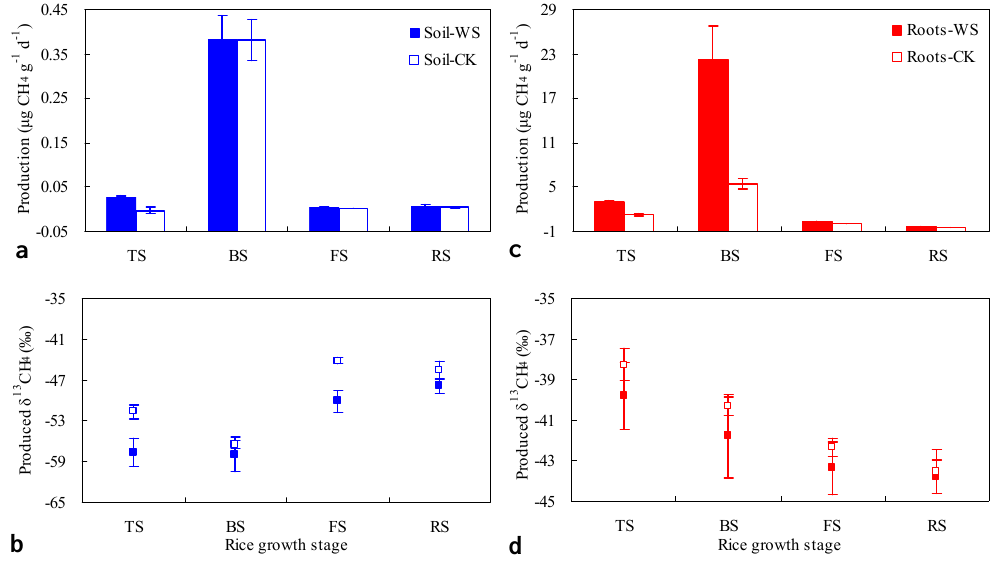
Fig. 3. CH 4 production in aerobically incubated paddy soil (a) and rice roots (c) , and corresponding δ 13 C-values of CH 4 ( (b) and ( d )) at the four rice growth stages. TS: tillering stage, BS: booting stage, FS: grain-filling stage, RS: ripening stage. WS: straw incorporation, CK: without straw incorporation. Mean ± SD, n = 3.